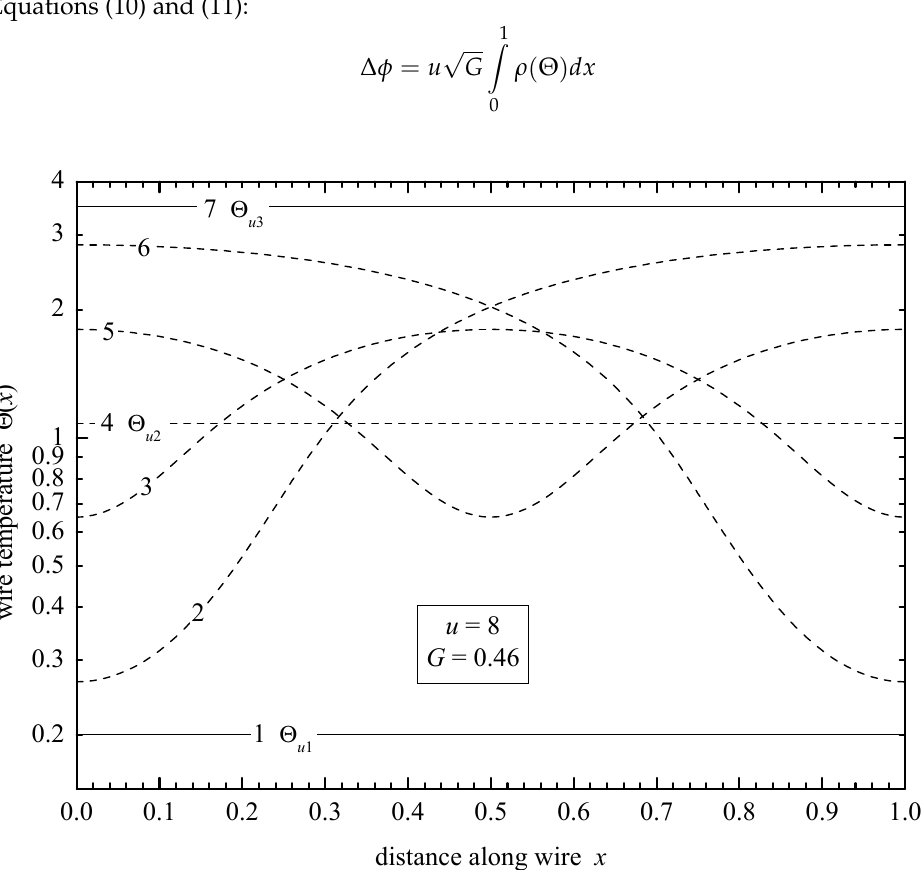
Figure 6. Wire temperature distributions for 𝐺 = 0.46 and 𝑢 = 8 .